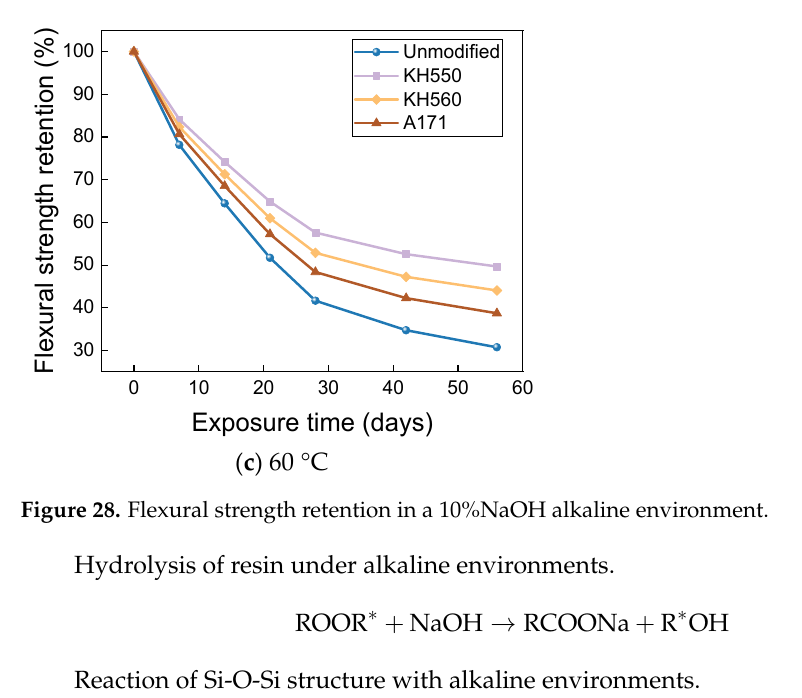
Reaction of Si-O-Si structure with alkaline environments.